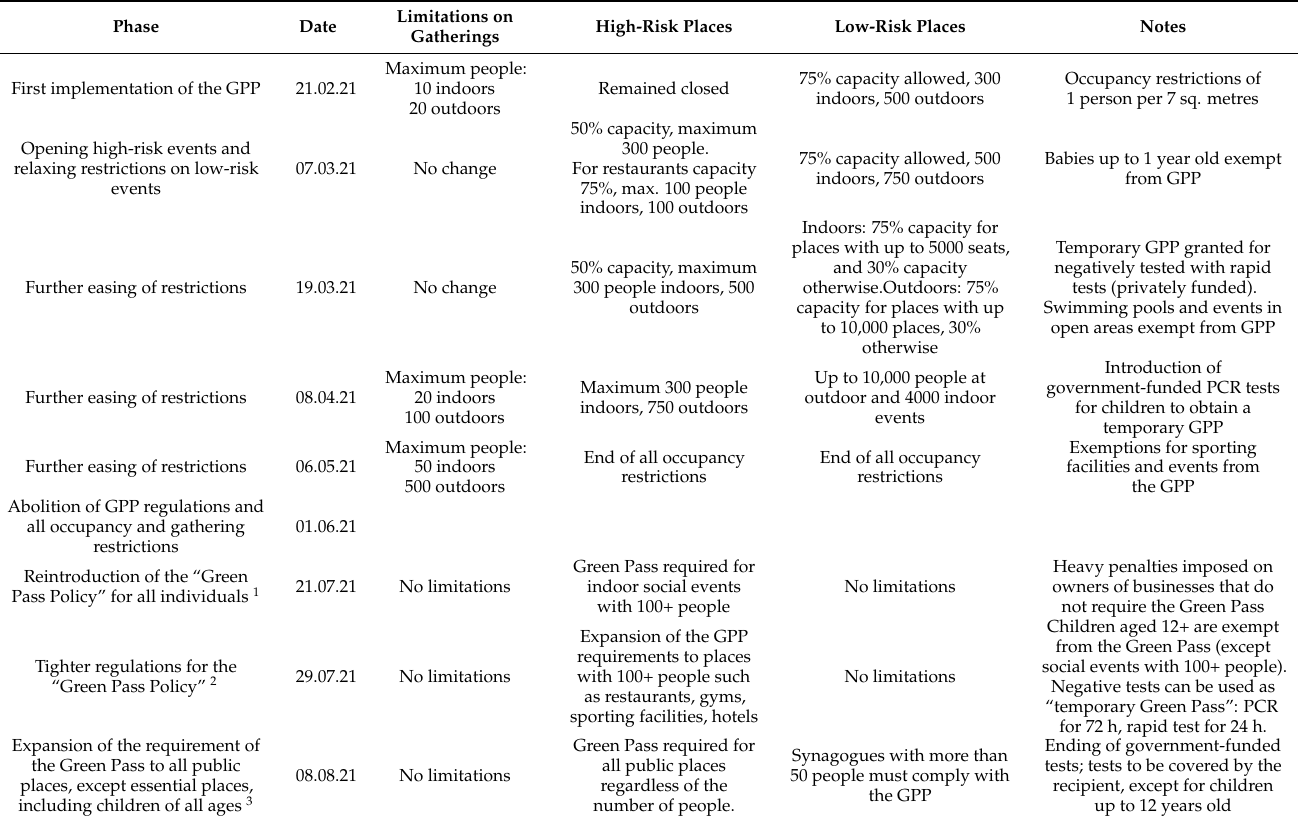
Table 1. Development of GPP